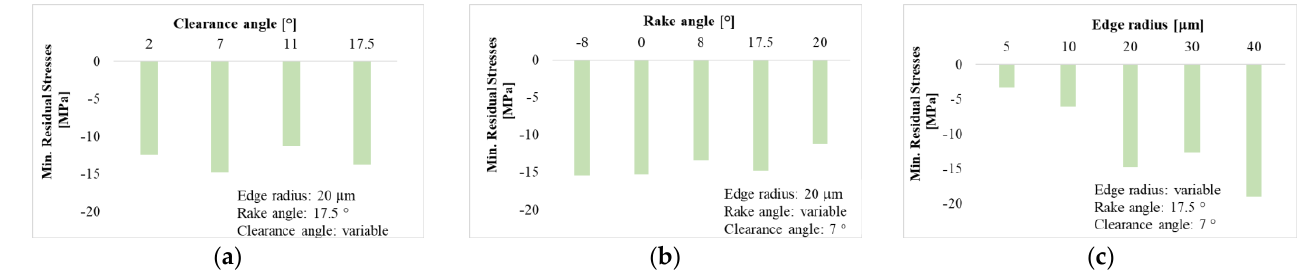
Figure 25. Effects of the tool geometry on minimum residual stress: ( a ) clearance angle, ( b ) rake angle, and ( c ) nose radius.